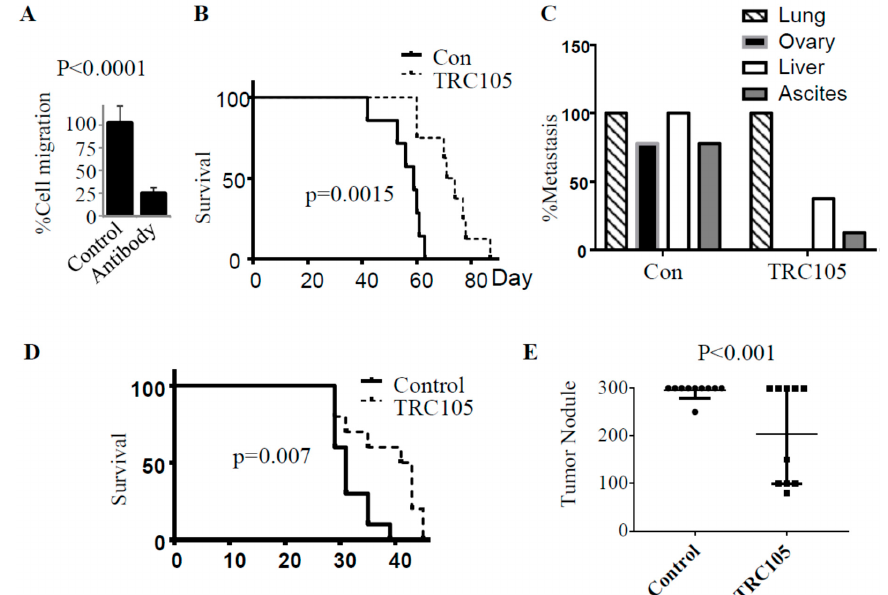
Figure 6. Impact of CD105 neutralizing antibody on ovarian metastasis and survival. ( A ) Summary of OVCAR3 cell migration in the presence or absence of CD105-neutralizing antibody. The experiment was repeated three times. Migration was normalized to that of control cells, defined as 100%. ( B ) Kaplan–Meier survival curve of mice injected intravenously with OVCAR3 cells and treated with control vehicle ( n = 9) or TRC105 CD105-neutralizing antibody ( n = 8). ( C ) Metastasis incidence in the indicated organs in control and TRC105-treated mice with IV-injected OVCAR3. ( D ) Kaplan–Meier survival curve of mice injected intraperitoneally (IP) with OVCAR3 cells and treated with control vehicle ( n = 10) or TRC105 CD105-neutralizing antibody ( n = 10). ( E ) Average number of abdominal tumor implants in control and TRC105-treated mice with IP tumor injection ( N = 10 per group, p < 0.001). For quantification, tumor nodule numbers over 300 were estimated as